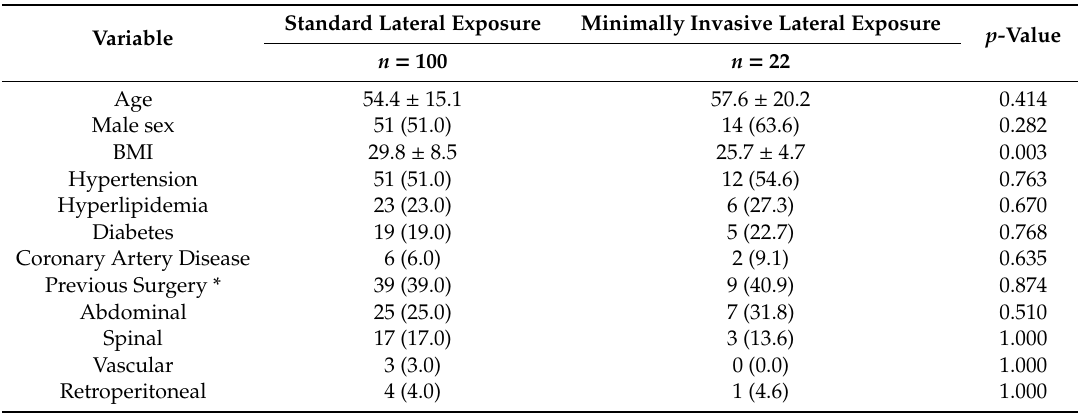
Table 1. Demographic data † .